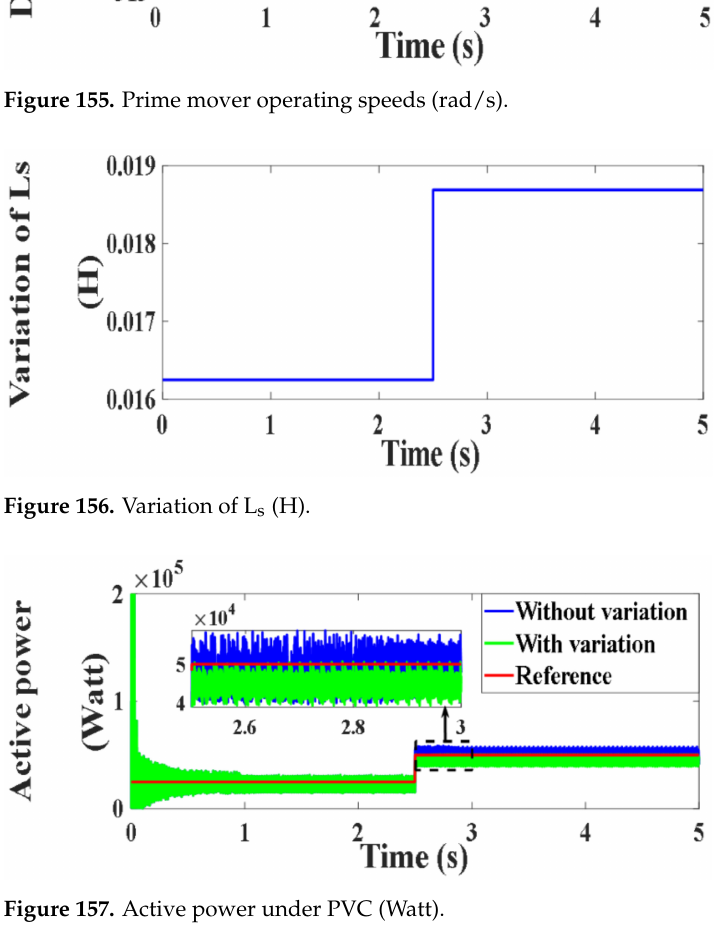
Figure 157. Active power under PVC